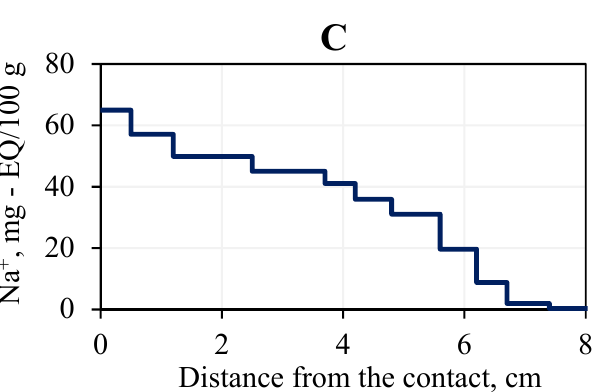
Figure 7. Variations of Na + contents along frozen hydrate-bearing sand samples after four hours of interaction with 0.1 N ( A ), 0.2 N ( B ), and 0.4 N ( C ) NaCl solutions, at − 6.5 °C and 0.1 MPa. The contents of Na + that migrated to the samples affect the distribution of gas hy- drates (hydrate coefficient patterns). Hydrate constituted about 40% of pore moisture in the samples before the interaction with the NaCl solution and decreased progressively away from the contact after the interaction. After four hours of interaction at a constant temperature of − 6.5 °C, the zone of decreasing hydrate coefficient expanded from 2.5 cm at 0.1 N to 5.6 cm at 0.4 N NaCl concentration (Figure 8) and covered the sample part where residual hydrate was present.